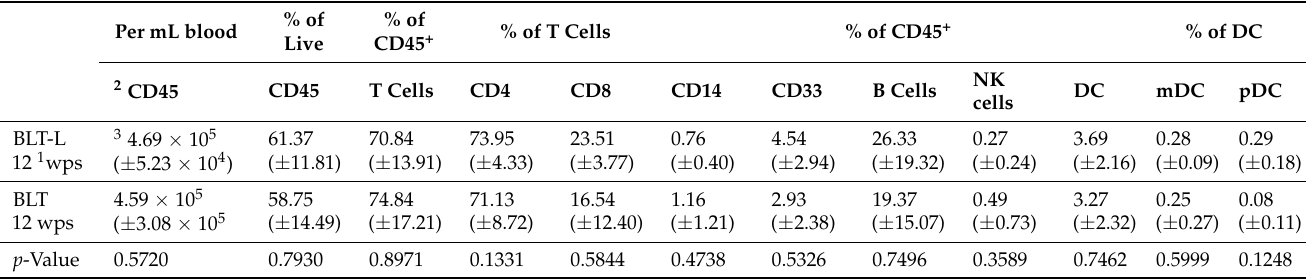
Table 1. Comparison of human immune cell reconstitution in the peripheral blood of TKO-BLT and TKO-BLT-L mice at 12 weeks